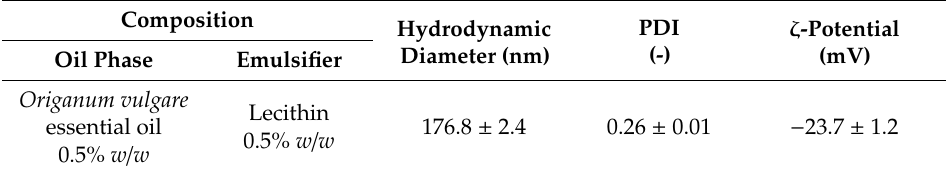
Table 2. Formulation and physical characterization of oregano essential oil (OEO) nanoemulsion.